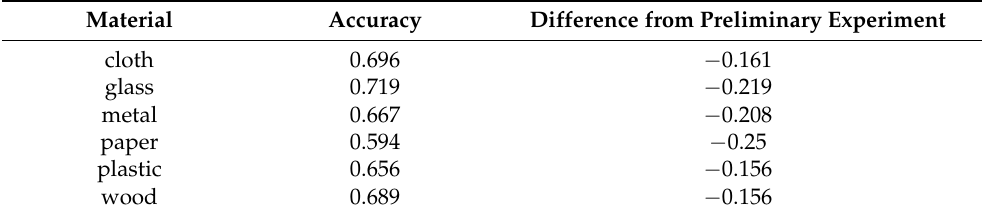
Table 9. Accuracy of each material class and difference between main and preliminary experiments.